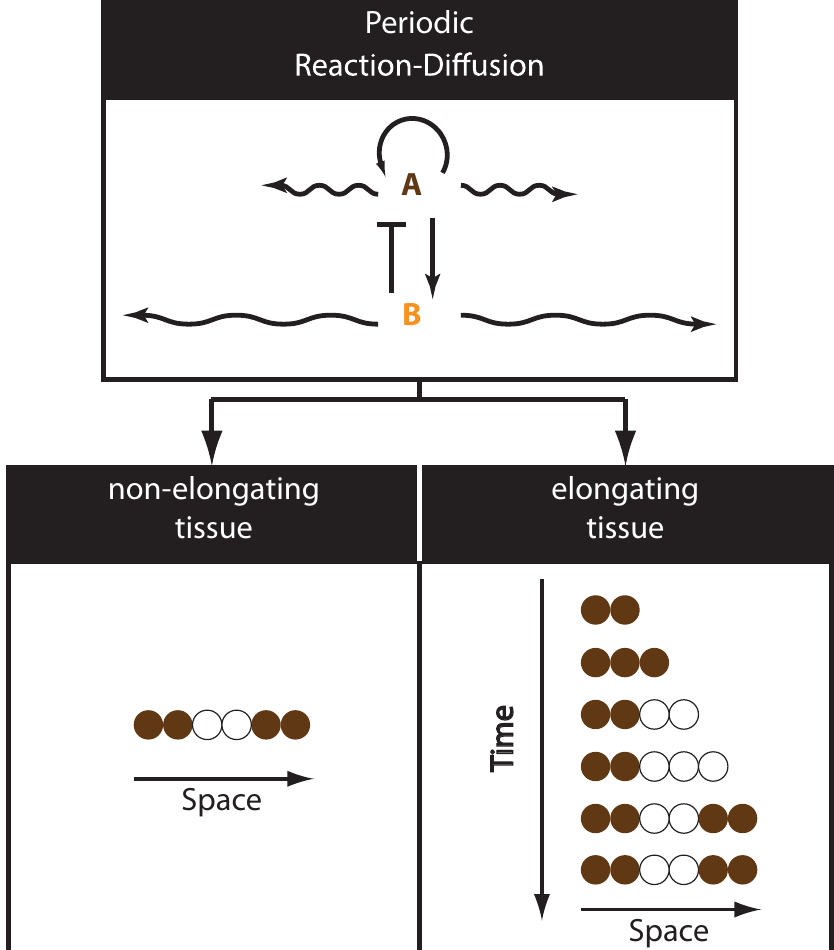
Fig 5. The RD model (see also Box 2). In the RD model (top panel), a slow-diffusing molecule (molecule A) activates itself as well as a fast-diffusing molecule (molecule B), which is also an inhibitor of A. The RD model can pattern nonelongating (bottom left) as well as elongating tissues (bottom right). RD,